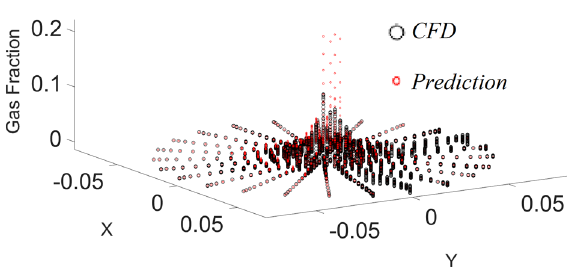
Figure 3. CFD pattern comparison with AI pattern. Red colour shows CFD and black dot shows AI